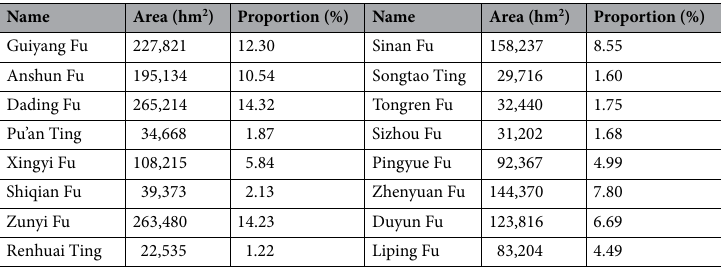
Table 4. Correction data of cropland